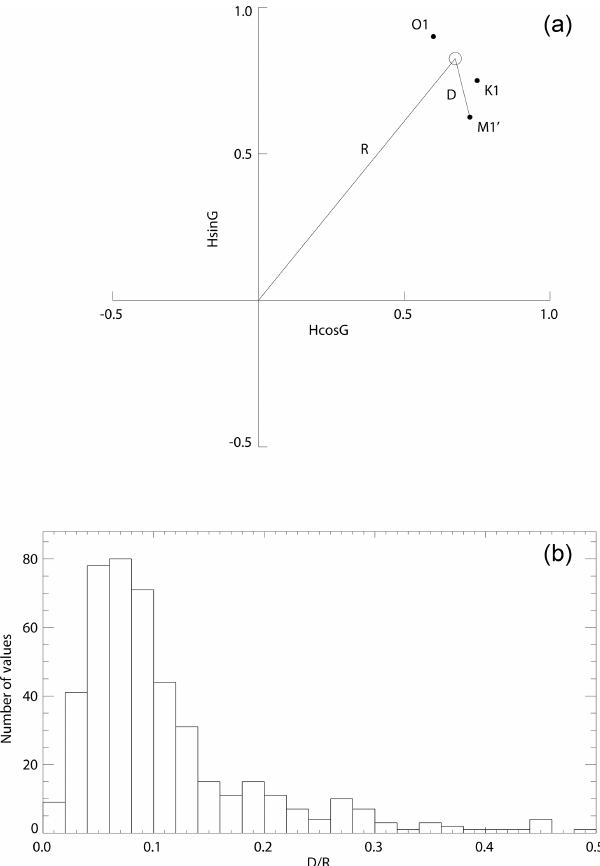
Figure 6. (a) A schematic example of the positions of K1 and O1 in the complex plane, their midway position (open circle) and its amplitude ( R ), and the distance ( D ) between the measured M1’ and the midway point. (b) A histogram of values of the ratio D/R ob- tained from records in GESLA-2 requiring the amplitude of K1 to be at least